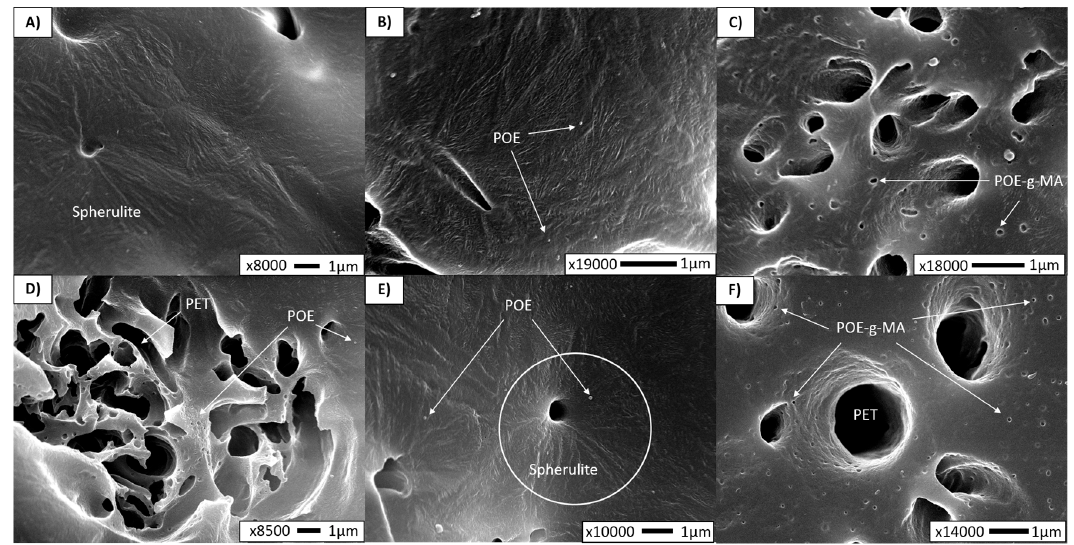
Figure 4. SEM micrographs of cryogenically fractured surface under liquid nitrogen of the injection moulded samples: ( A ) MFC (spherulite around fibril hole); ( B ) POE EXT (randomly oriented lamellae); ( C ) POE- g -MA EXT (non-reacted compatibilizer particles dispersed into matrix); ( D ) POE IM (rubber located at the interface); ( E ) POE IM (spherulite orientation around the fibril hole); and ( F ) POE- g -MA IM (compatibilizer particles located at the interface).